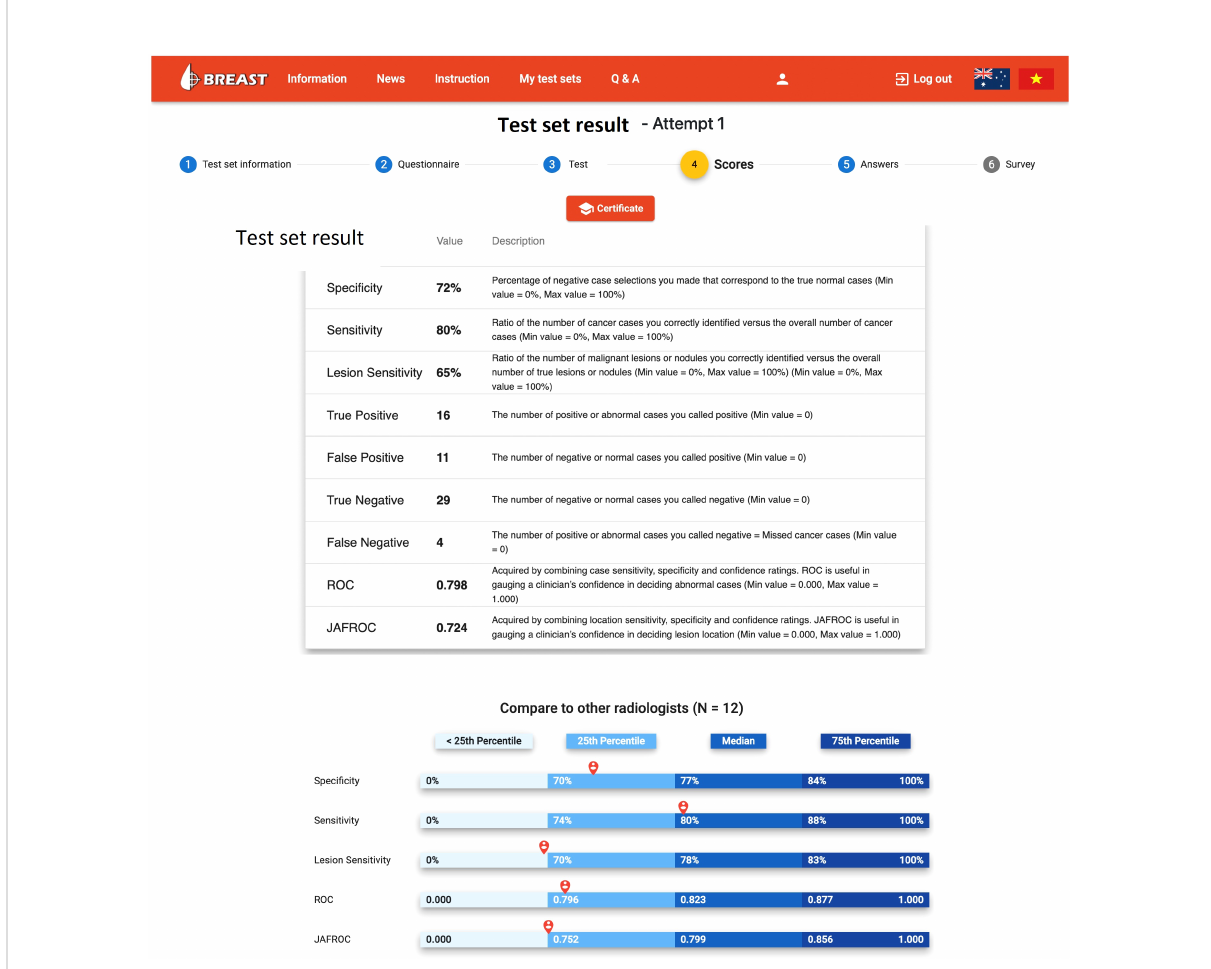
FIGURE 3 The diagnostic report on the BREAST platform to a radiologist when a mammogram test set is completed